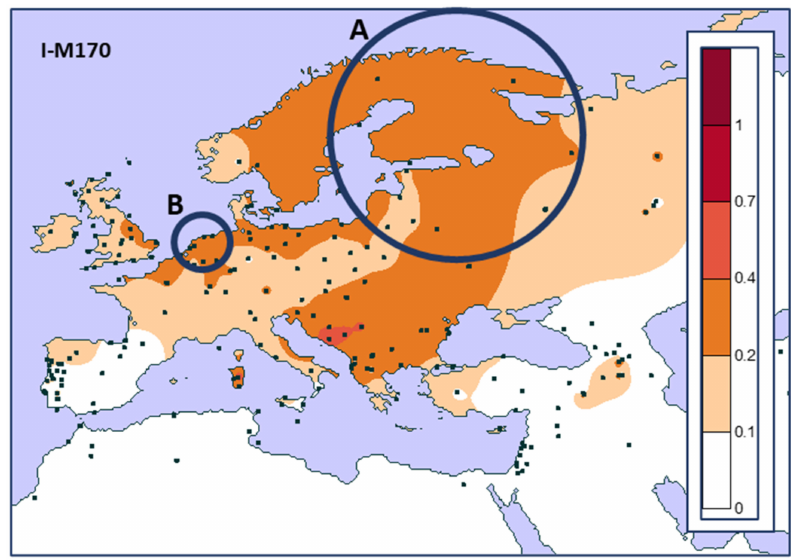
Figure 4. Prediction surface map of haplogroup I (M170) based on the frequencies from 144 sampling locations (shown as solid black squares) encompassing 2980 males. ( A ) Finland and neigbouring regions, see main text. ( B ) The Netherlands, see main text. The spatial patterns were created using ordinary Kriging interpolation implemented in Surfer software (version 7, Golden Software Inc., Golden, CO, USA) and shown with a 10% gradient step.